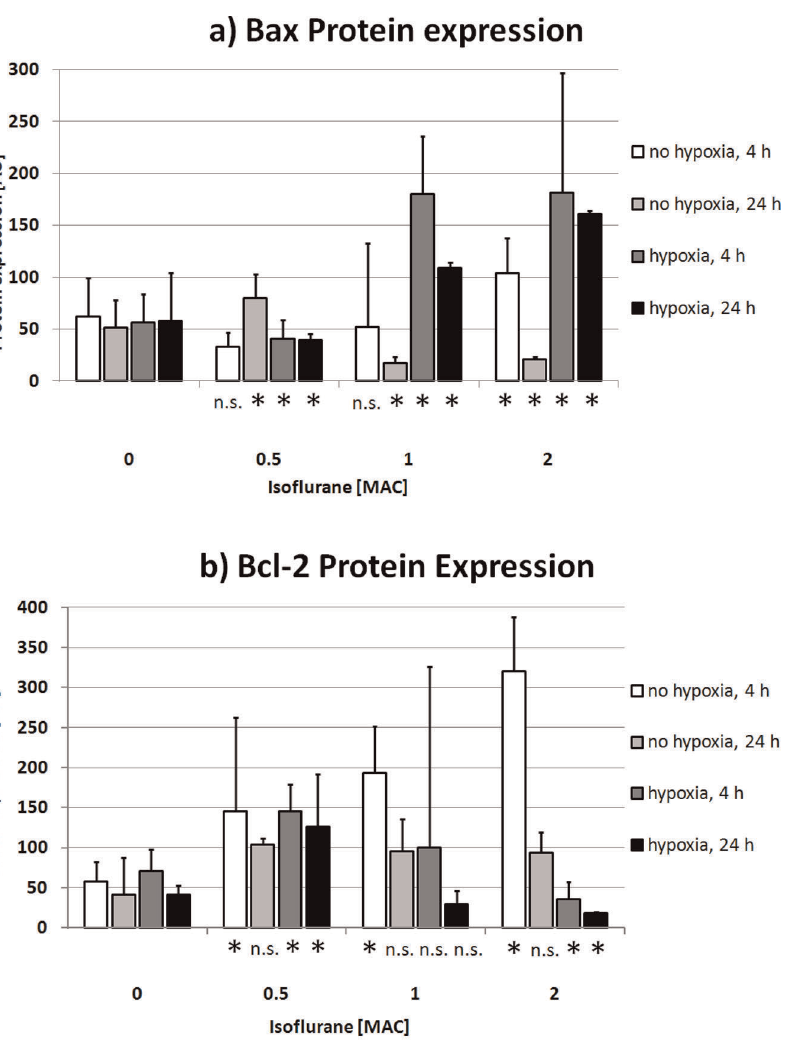
Figure 3. Bax/Bcl-2 Western Blot bar graphs. Median value and interquartile range of Bax (a) and Bcl-2 (b) protein expression in relation to hypoxic challenge and recovery period (4/24 h). N.s.: not significant, *: statistically significant difference to control/0 MAC in Mann-Whitney